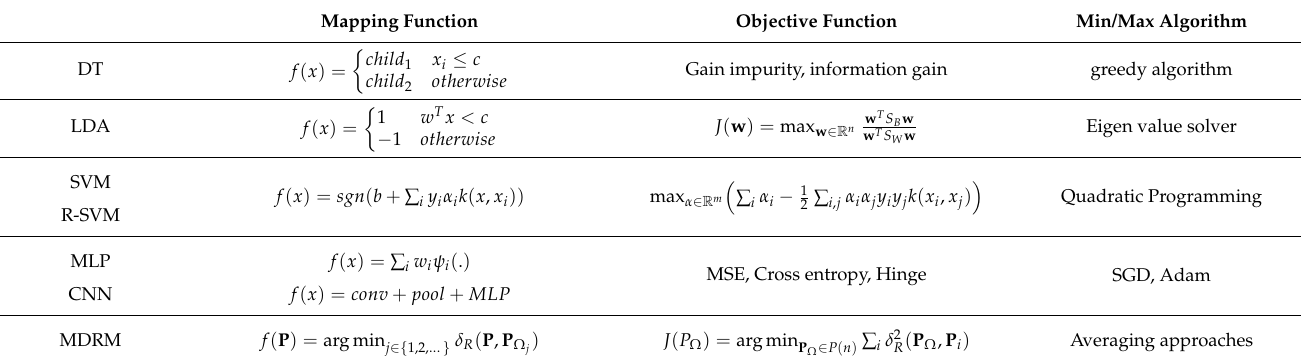
Table 2. This table provides a summary of the classification methods described in the Section 2.7. Mapping Function Objective